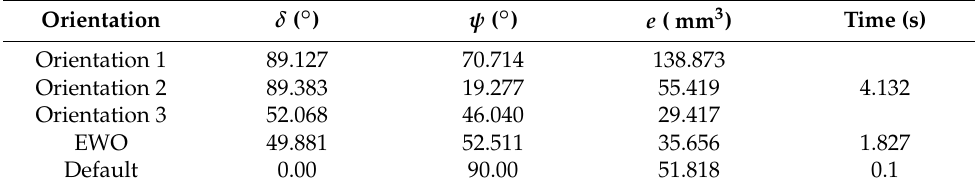
Table 1. Volume error comparison in different